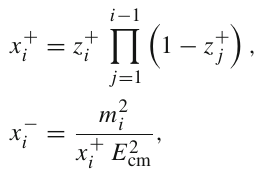
represented by dashed and h